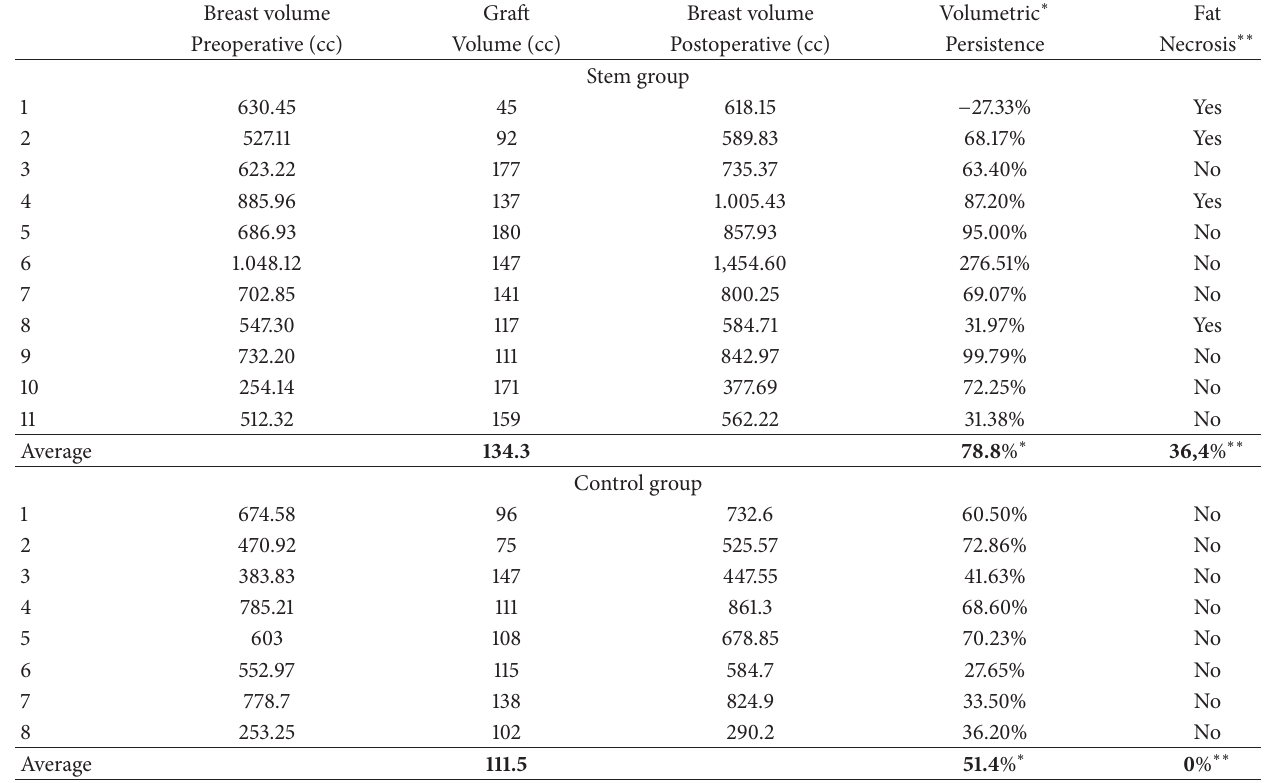
Table 4: Volumetry and fat graft